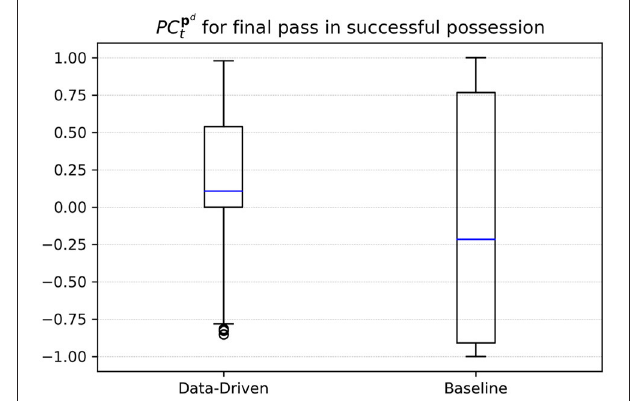
time t whereas PC t ( p ) = 1 means that the offensive team controls that area.